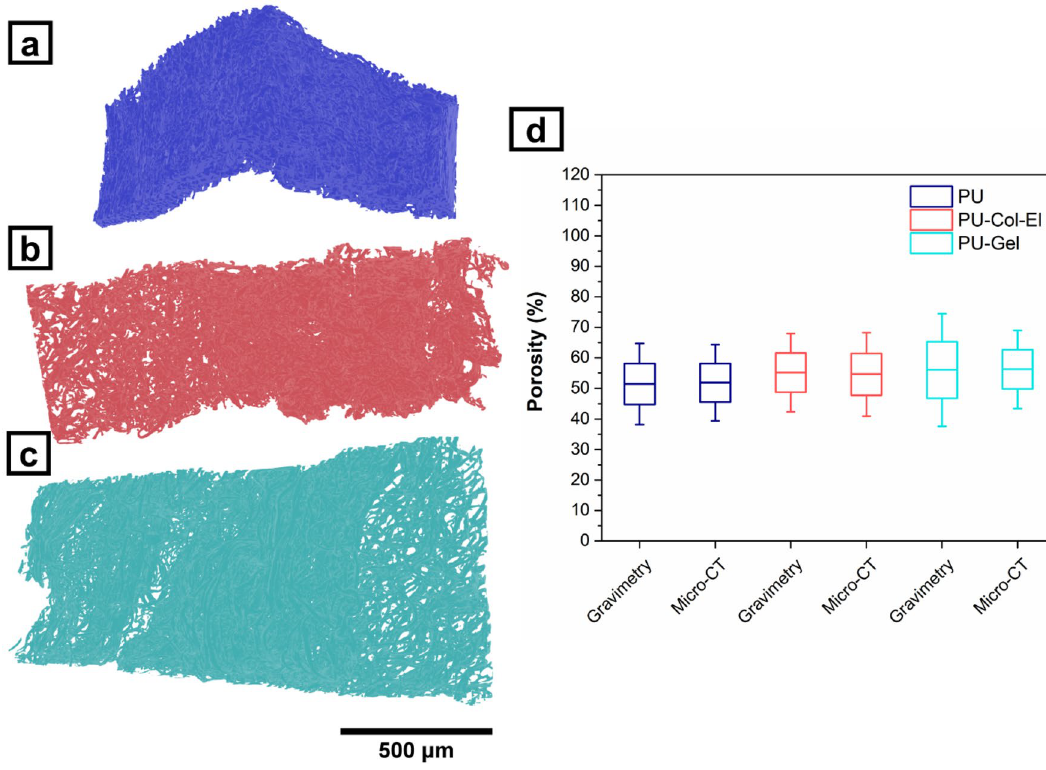
Figure 2. Micro-CT images of PU ( a ), PU-Col-El ( b ), and PU-Gel ( c ) scaffolds and porosity results obtained by micro-CT and gravimetry ( d ).